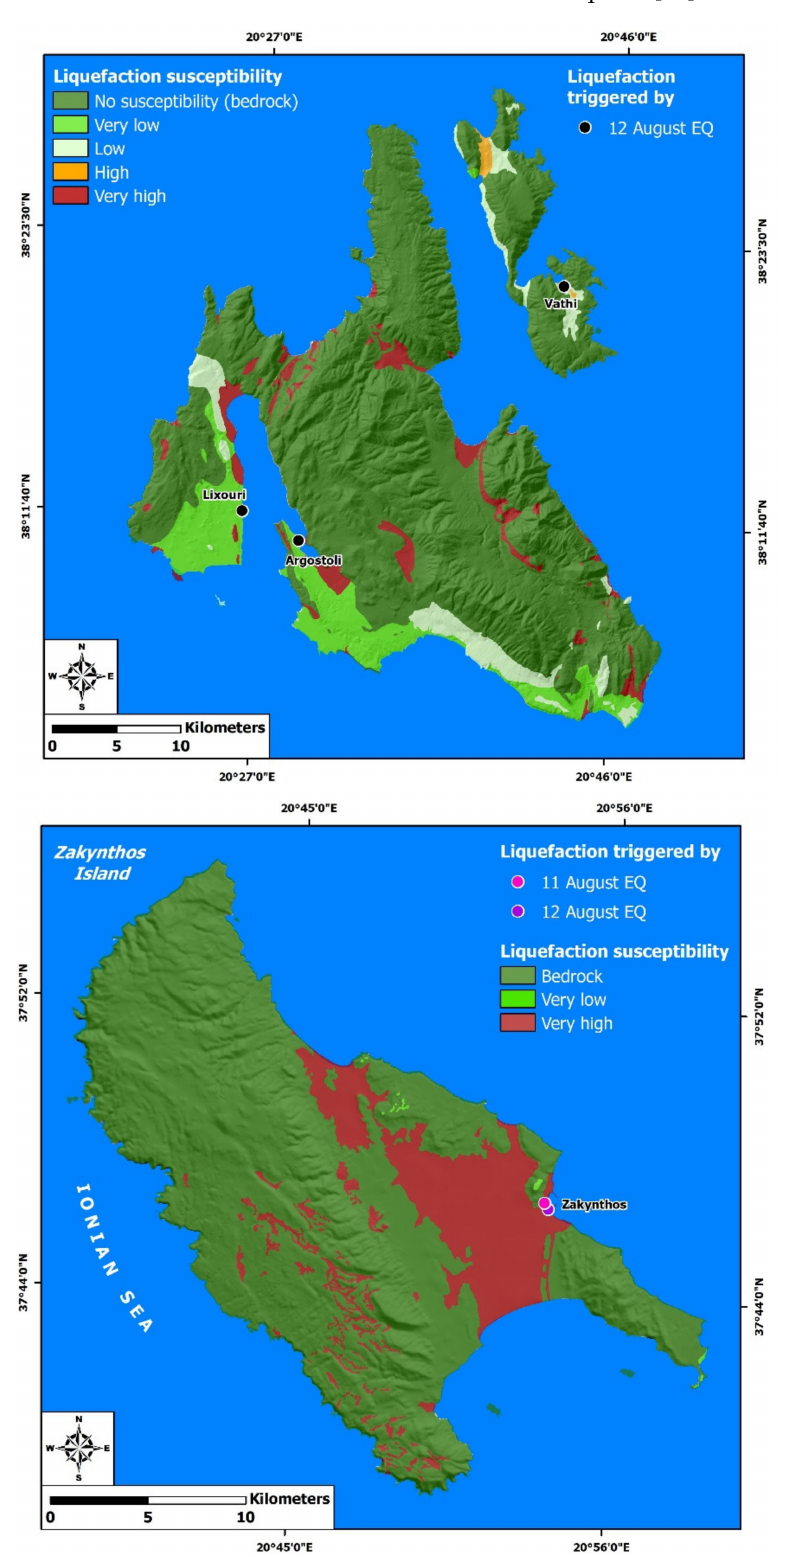
Figure 19. Comparison of the inventory of liquefaction triggered by the August 1953 earthquakes in Cephalonia and Zakynthos with the liquefaction susceptibility maps of the